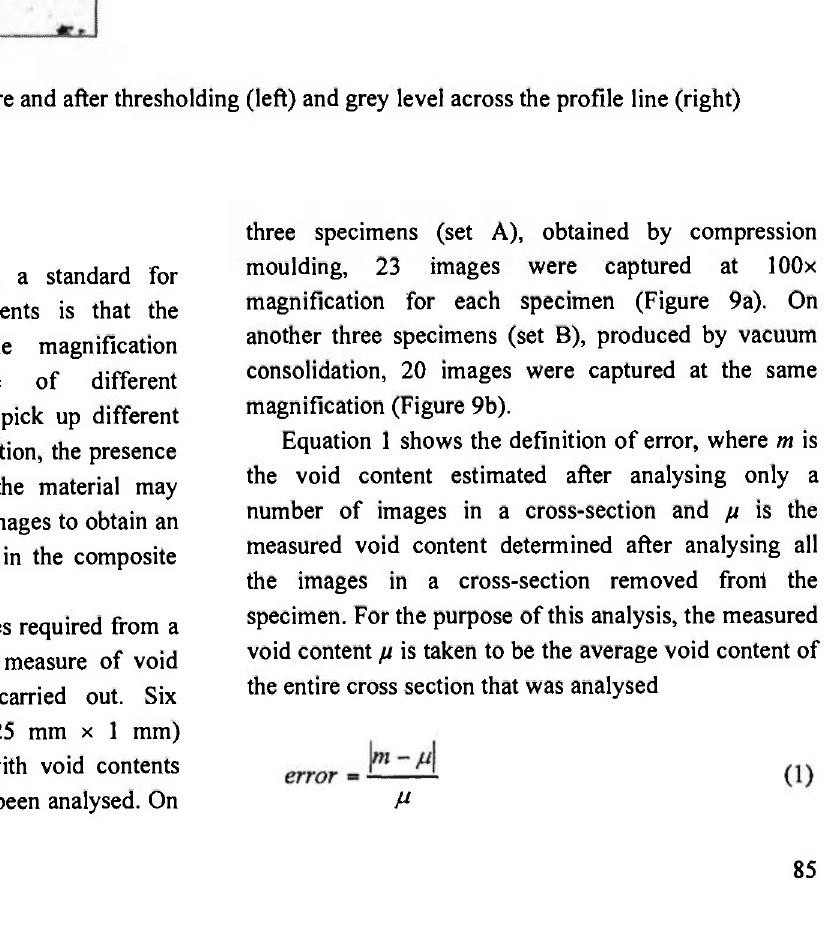
Fig. 8: Photomicrograph before and after thresholding (left) and grey level across the profile line